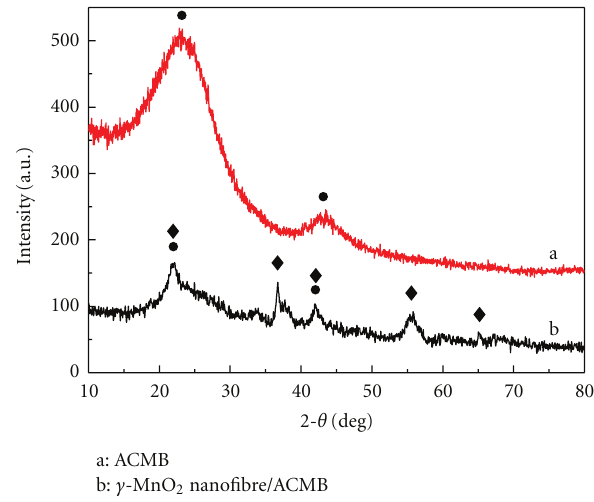
Figure 2: XRD patterns of ACMB and γ -MnO 2 nanofibre/ACMB (the peaks of carbon and γ -MnO 2 are noted with ( • ) and ( (cid:2) ),